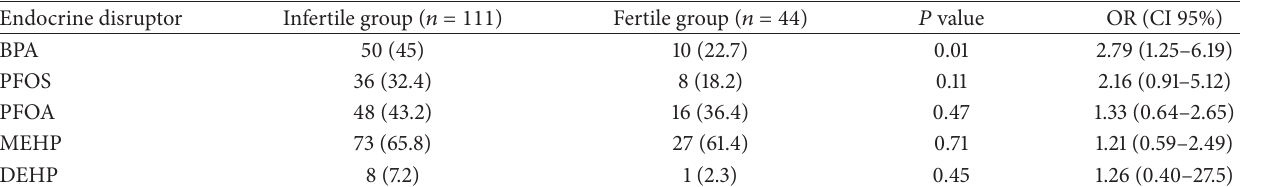
Table 1: Proportion of samples with EDC levels > LOD in both infertile and fertile groups.